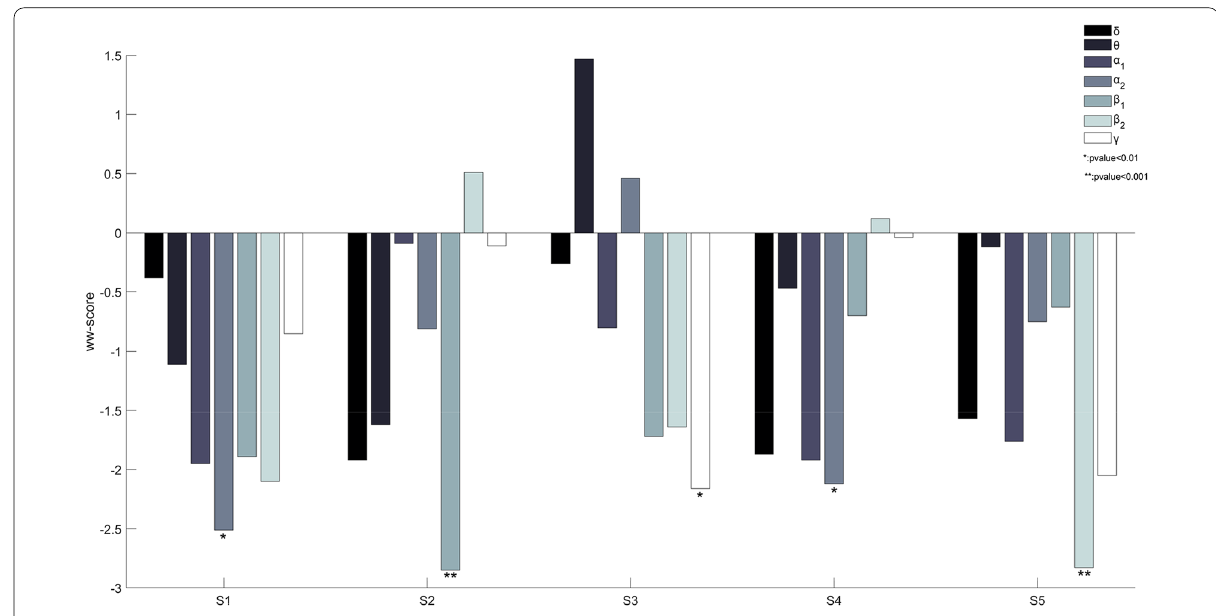
Fig. 4 The obtained ww-scores for the static dataset. Low ww-score levels indicate high separability between “buy” and “no-buy” brain